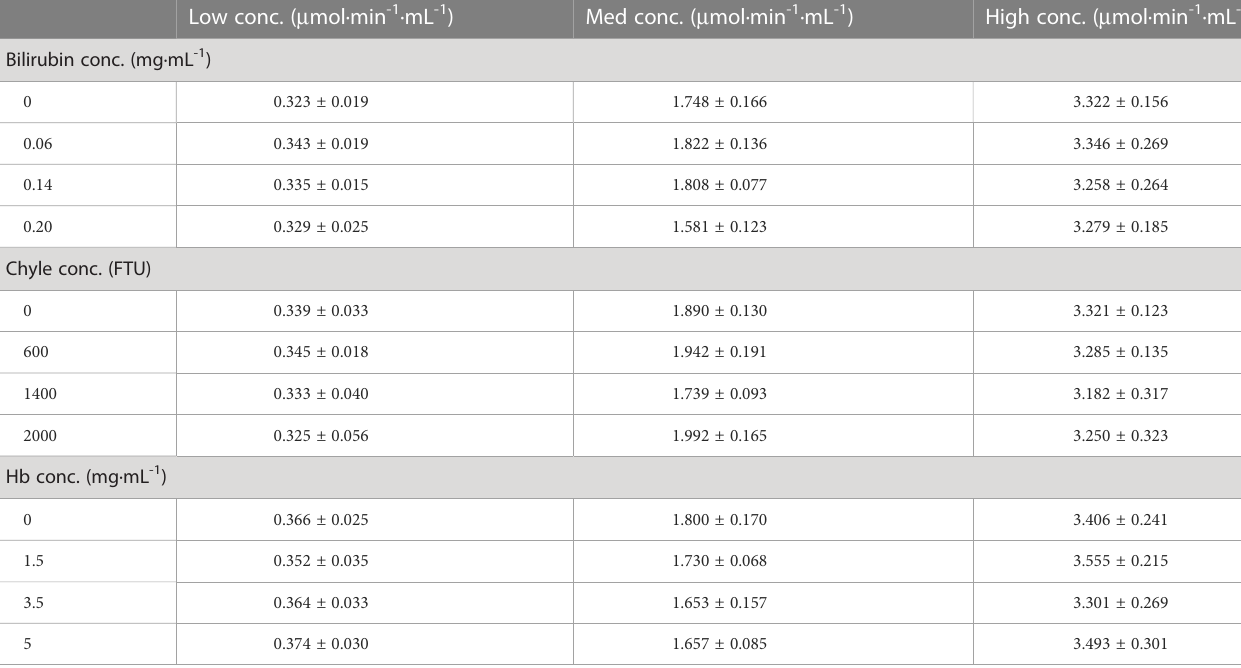
TABLE 5 Interference of C1s activity assay by bilirubin, chyle and hemoglobin ( n =